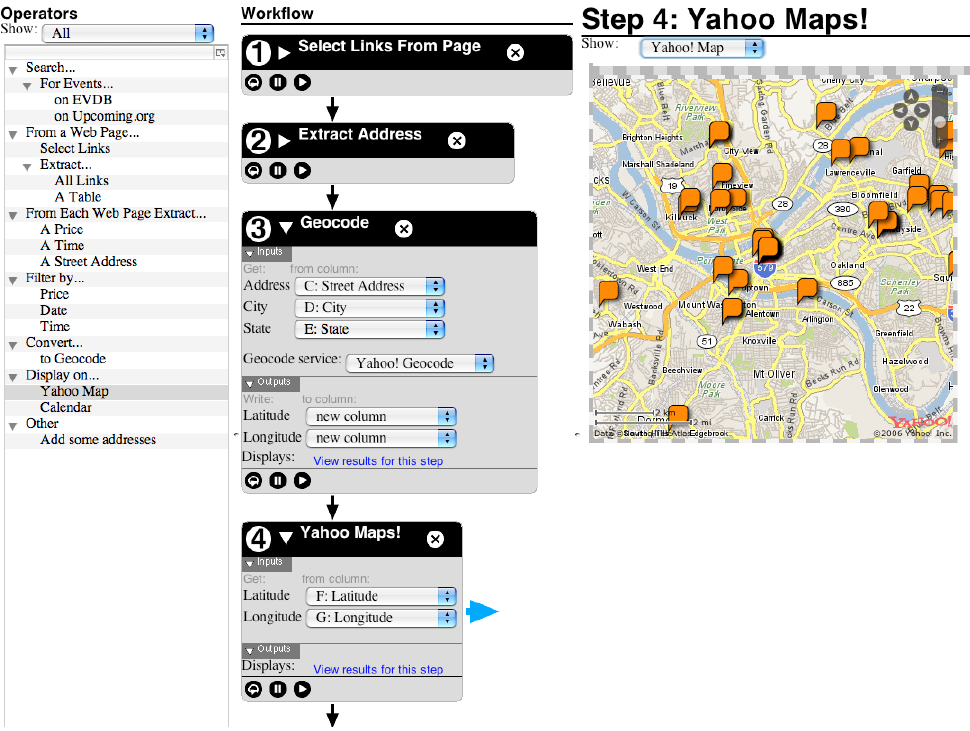
Figure 10. HousingMaps programmed in MARMITE. Open Mashups